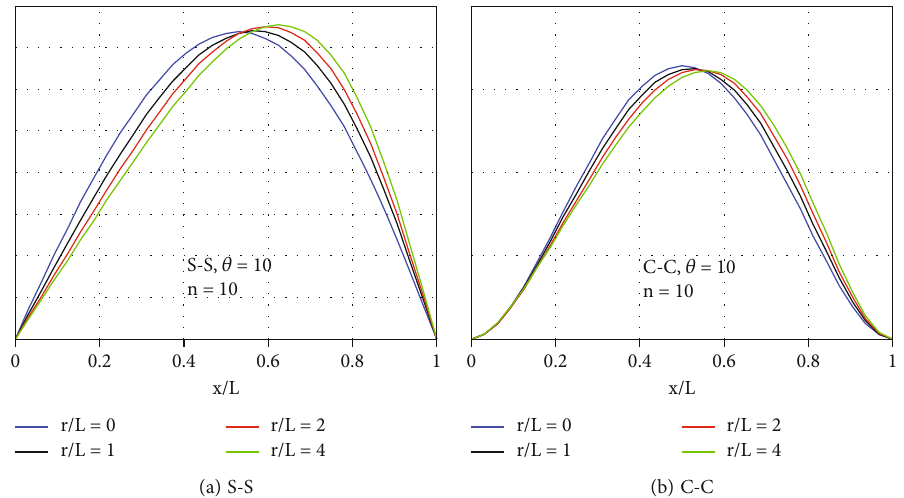
Figure 7: The fi rst four vibrational shapes of the rotating piezoelectric FG beam ( n = 10 , r = 0 ).